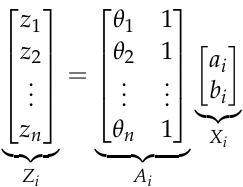
dot markers represent the linear boundaries found for each